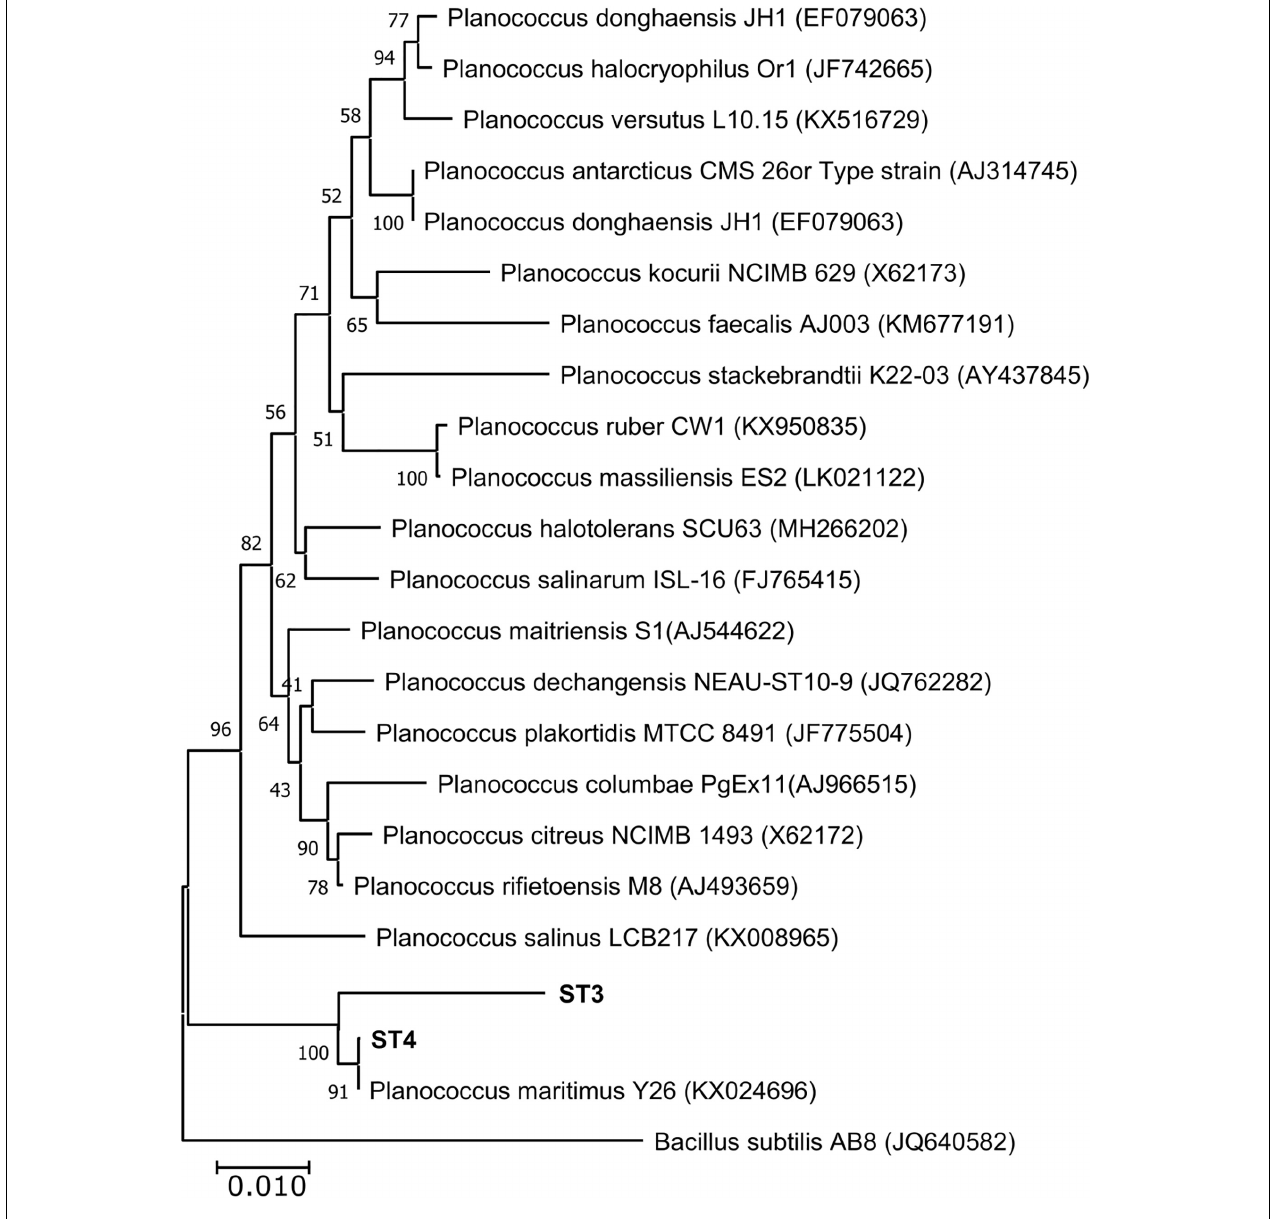
FIGURE 2 | Neighbor-joining phylogenetic tree showing the relationships between the salt-tolerant Planococcus strains from the present study (ST3 and ST4) and the closely related species. All ambiguous positions were removed for each sequence pair (pairwise deletion option). Bacillus subtilis AB8 was used as the out–group.